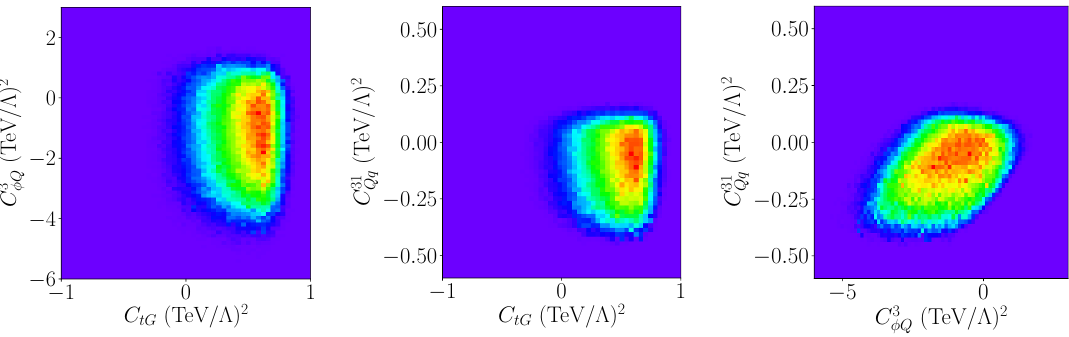
Figure 12 . Examples of correlated 2-dimensional pro(cid:12)le likelihoods from the global (cid:12)t, showing the same operators as in the lower panels of (cid:12)gure 10.